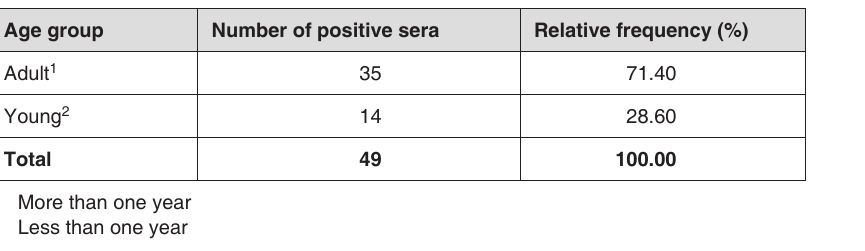
TABLE 3 Distribution of positive goat sera by age group